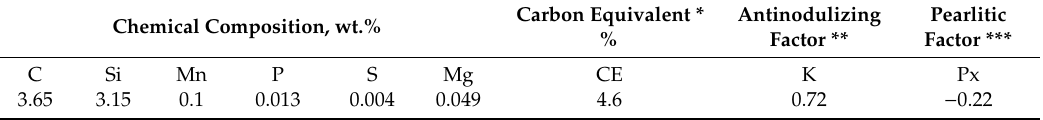
Table 2. Chemical composition of Mg-treated and inoculated cast